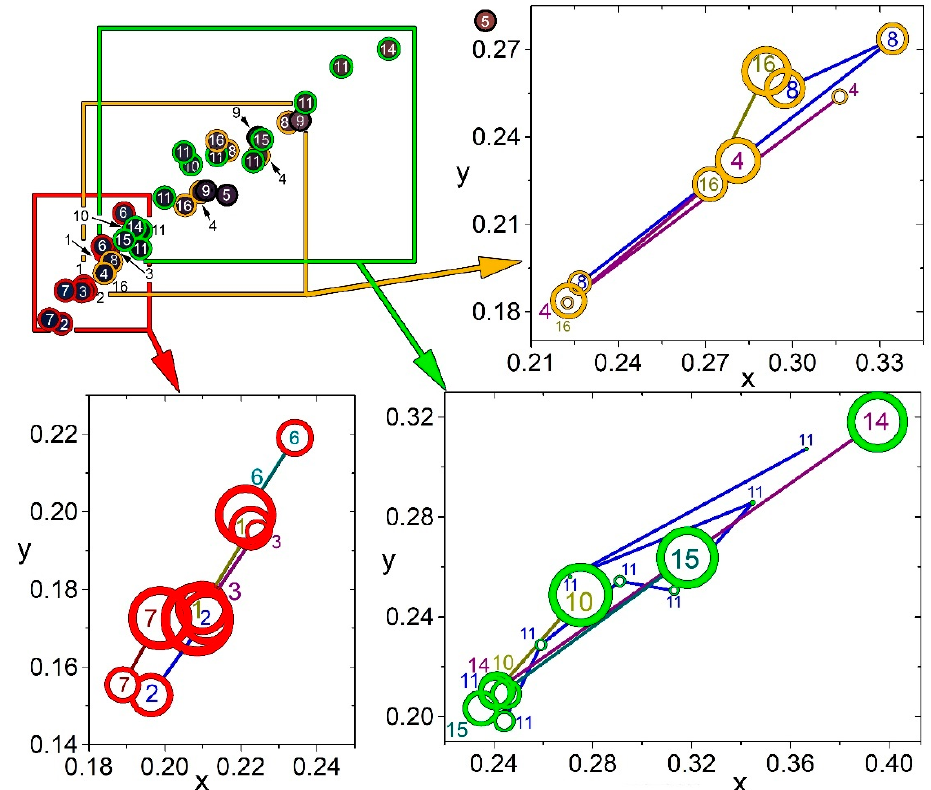
Figure 5. The color clusters position (open dots) as depicted in Figure 4, but now grouped and zoomed in three sets (red, green, and yellow) to highlight the chromatic similarities between the CL response of the different samples. The size of the open dots in the zoomed sets has been made proportional to the size of the corresponding color cluster.